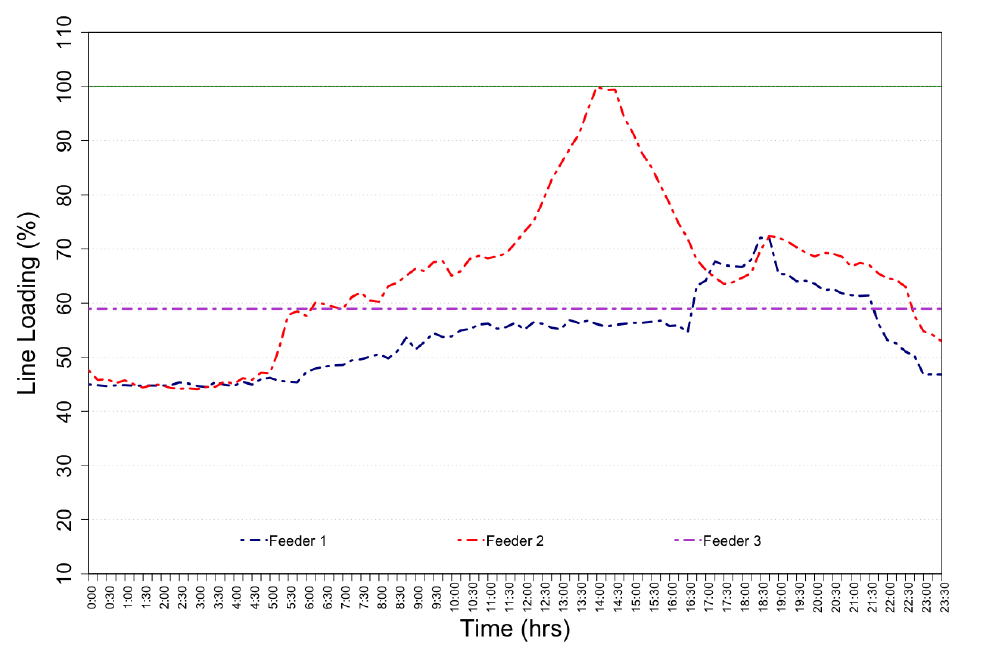
Figure 5. The combination of customers selected by the proposed DR framework restoring the line loading level of Feeder 2 back to normal operating limits.